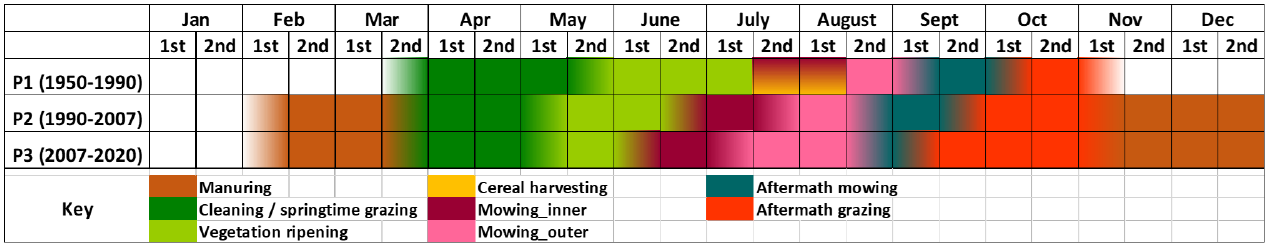
Fig. 5 . The timing of grassland management practices that are important from the point of view of the time of mowing to the annual cycle. The diagram shows the times described as optimal by local farmers but does not show the date of 1st of July, given in the CAP subsidy